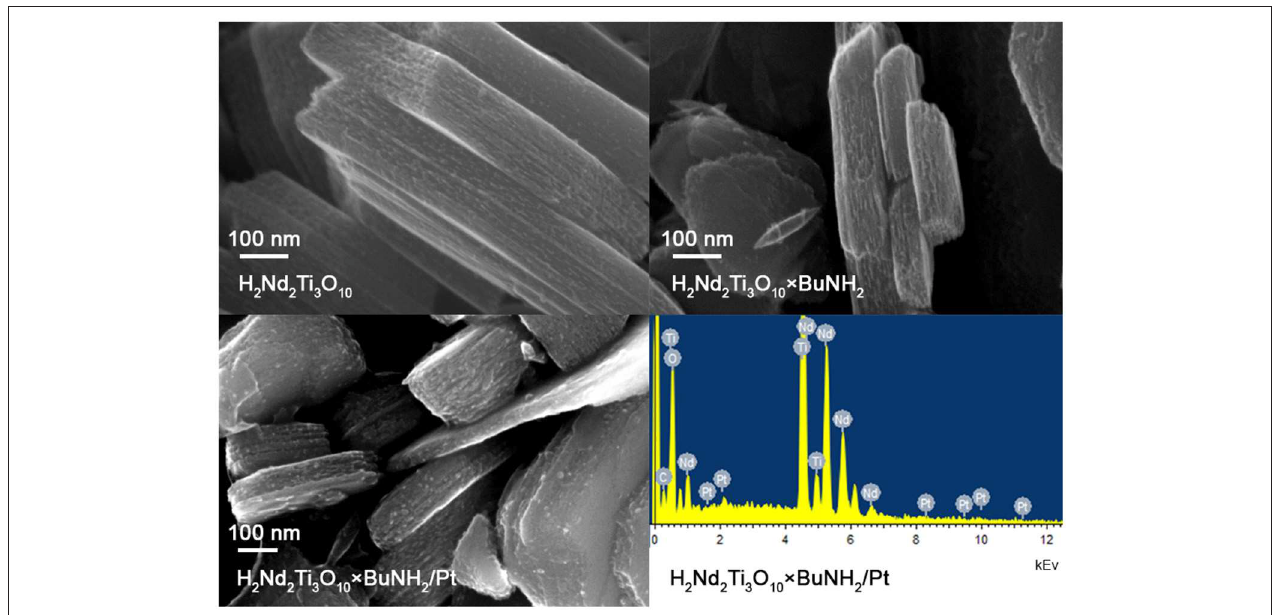
FIGURE 8 | SEM images of initial H 2 Nd 2 Ti 3 O 10 and H 2 Nd 2 Ti 3 O 10 × BuNH 2 samples, SEM image and EDX spectrum for H 2 Nd 2 Ti 3 O 10 × BuNH 2 /Pt sample after the photocatalytic experiment in 1% methanol solution.